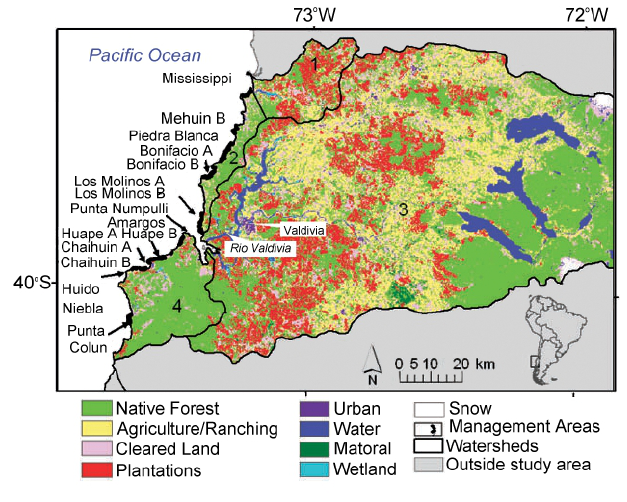
Fig. 1 . Study Site in the Valdivia-Province Coastal System, Chile. The management areas are located in black along the coast. In some cases two management areas are listed due to space constraints (i.e., Huape A and Huape B). Watersheds are numbered from 1 to 4. Some fisher syndicates have more than one management area. The influence of forest plantations (high chlorophyll-a concentration values in the nearshore and loco shellfish with high levels of shell-boring organisms) extends from the outlet of Rio Valdivia (the river from the Valdivian watershed, #3) northward (management areas Punta Numpulli